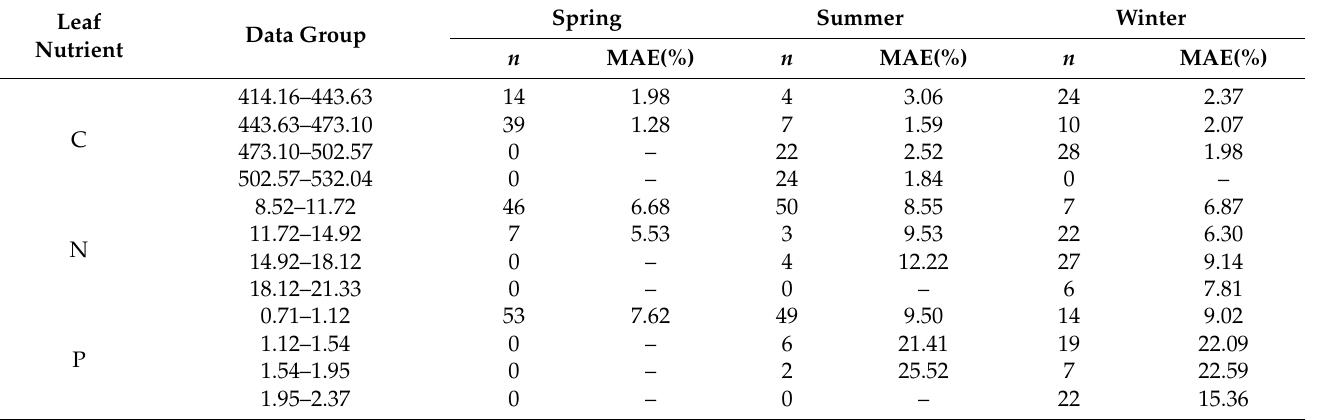
Table 10. The mean absolute error (MAE) of measured versus estimated leaf nutrients in different data groups based on the scatter points of Figure